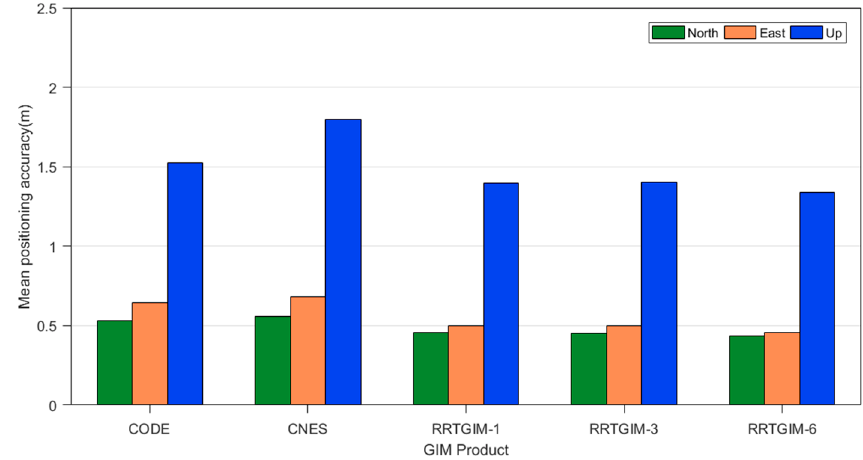
Figure 17. Positioning accuracy over 22 days for SF-PPP using VTEC products.